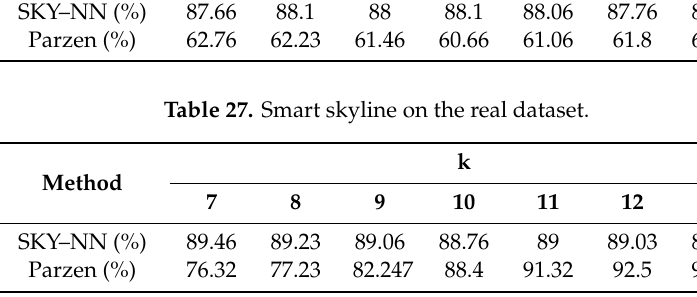
Table 25. Double skyline on the real dataset.